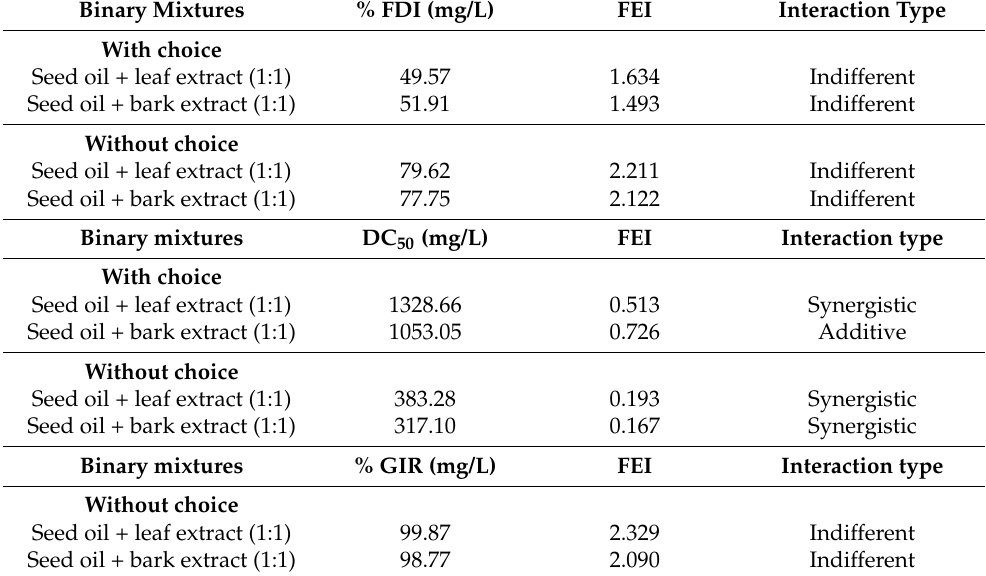
Table 6. Joint action activities of seed oil with leaf and bark extracts of Triadica sebifera against Plutella xylostella